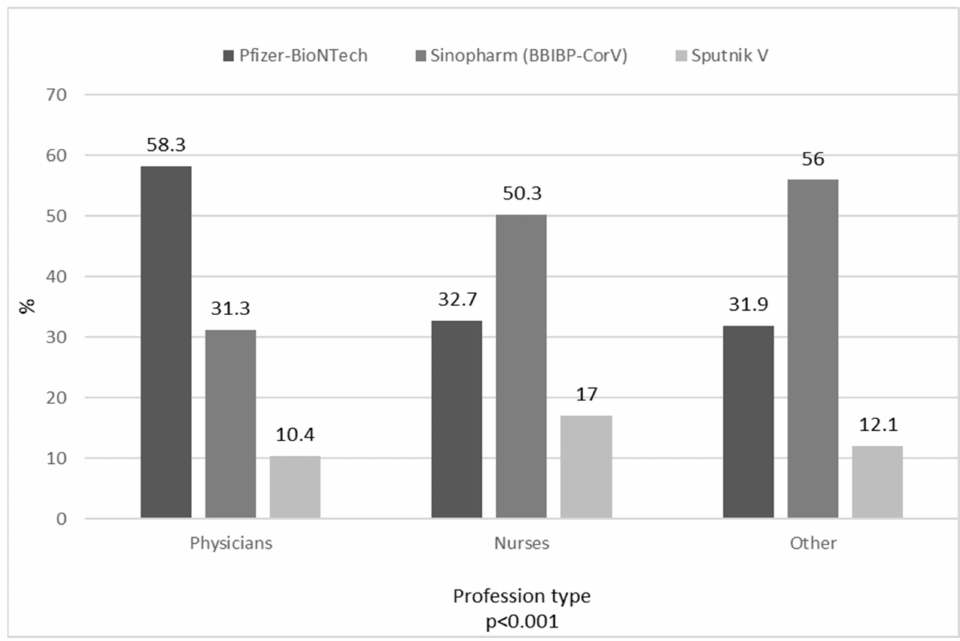
Figure 1. Vaccines administered to healthcare workers (vaccinated total, 383). Out of 403 HCWs who were vaccine-unsure or who did not intend to accept the COVID-19 vaccine before the beginning of COVID-19 immunization, 64.3% were vaccinated during 2021 (69.2% of vaccine-unsure, and 53.5% of those who had declared that they did not want to be vaccinated). Among IgG-negative HCWs, only 28% and 20% of